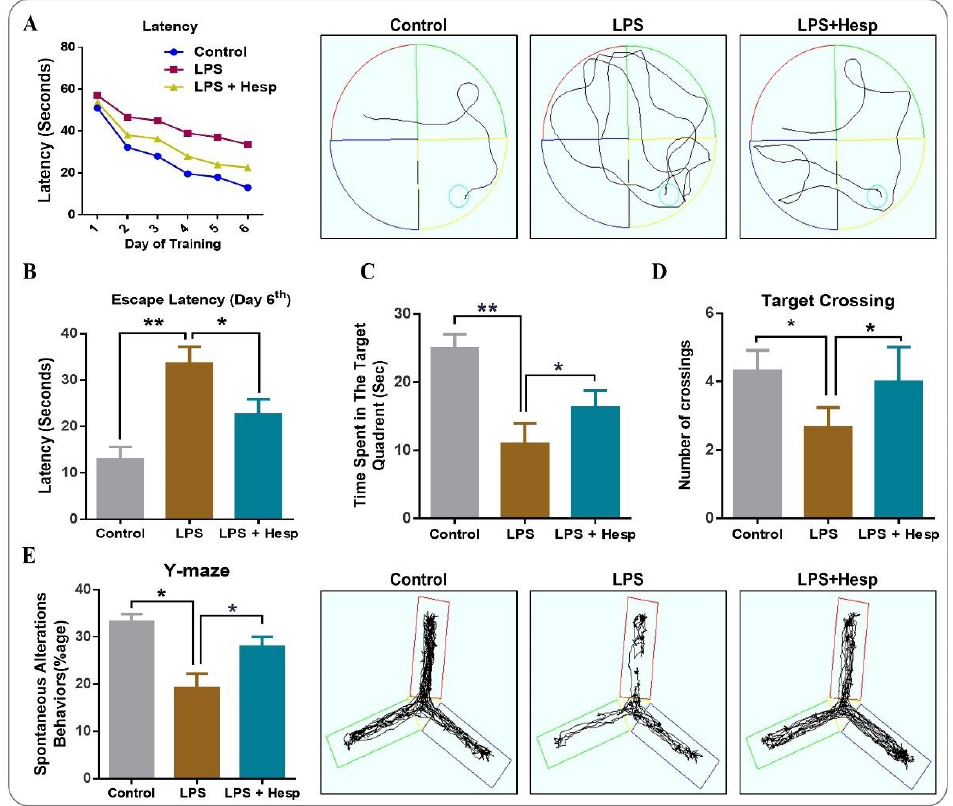
Figure 9. Hesperetin improved memory, learning, and cognitive behavior in LPS-treated adult mice: ( A ) mean escape latency to reach the hidden platform during training (5 days) with its representative trajectories at day-6 and ( B ) at the 6th day after training; ( C , D ) the time spent in the target quadrant where the hidden platform was previously present and the number of crossings over that location in the absence of a platform; ( E ) the Y-Maze analysis representing the spontaneous alteration behaviors of mice and its representative trajectories. The data are presented as the mean ± SEM of 8–10 mice per group and are representative of three independent experiments, * p ≤ 0.05, ** p ≤ 0.01.